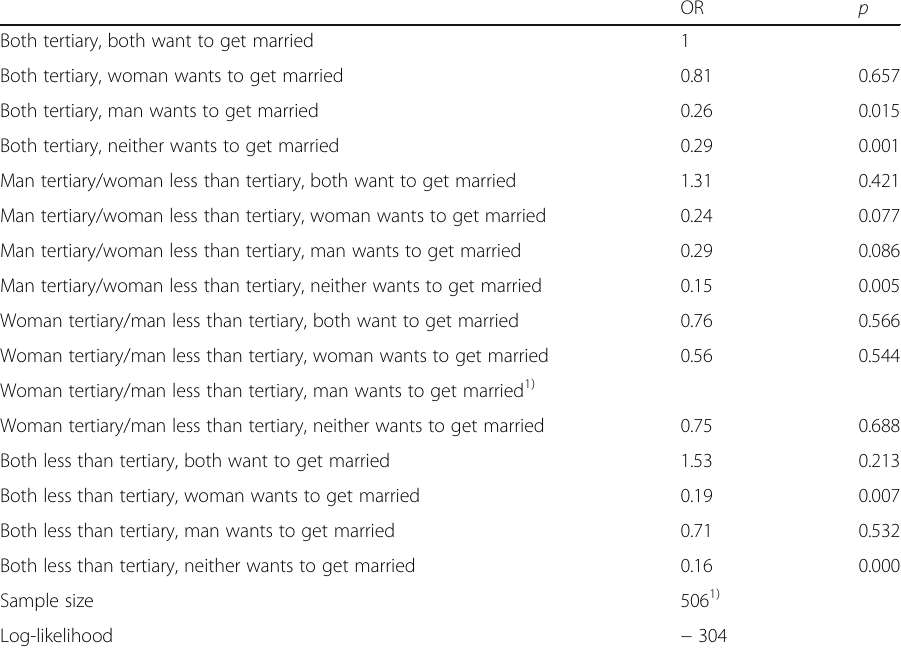
Table 7 Odds of marriage by interaction between marital intentions and education level ( n 507), and model adjusted for woman ’ s age, relationship duration, marital attitudes, and parental status